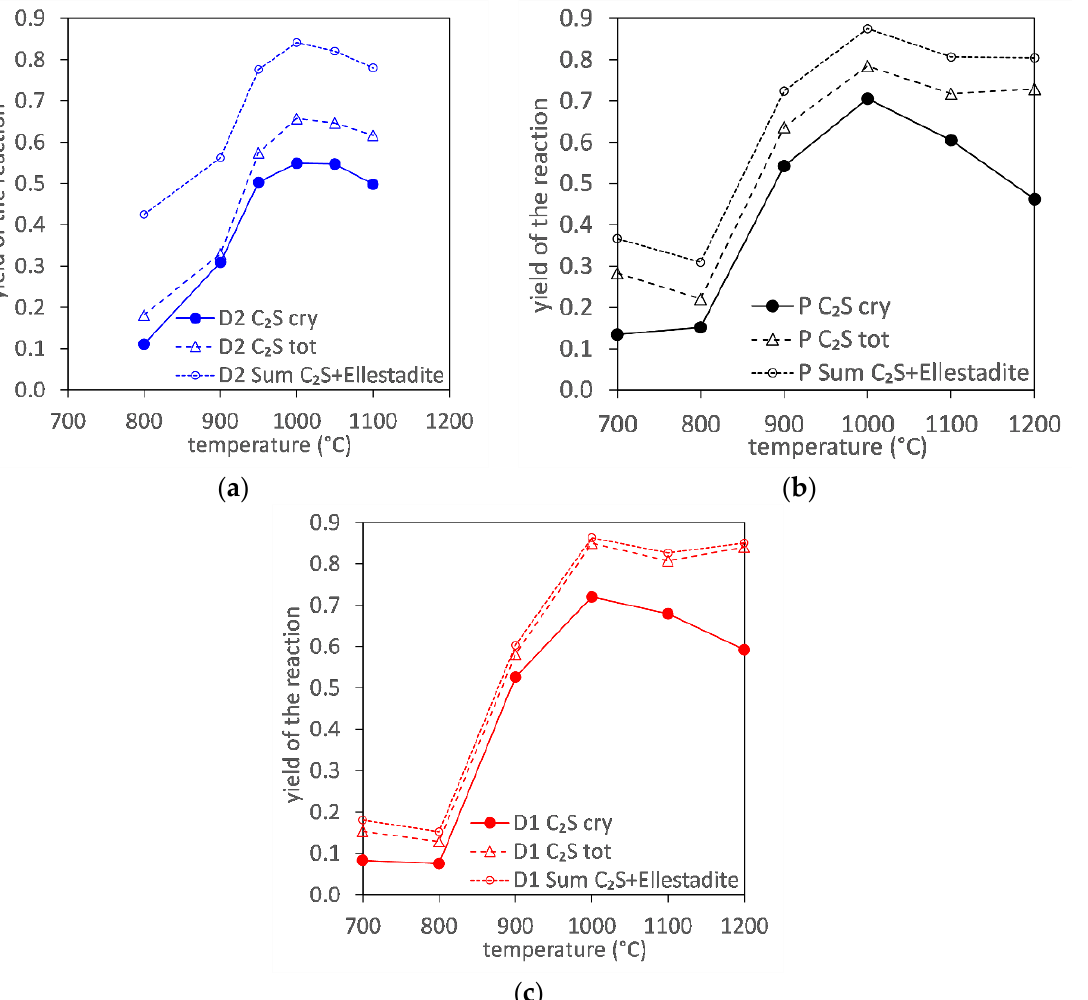
Figure 4. Yield calculated for the reaction to crystalline C 2 S, crystalline, and amorphous C 2 S and C 2 S + Ellestadite for samples D2 ( a ), P ( b ), and D1 ( c ) heated to temperatures from 700 to 1200 °C. C 2 S cry = sum of β - and α -C 2 S.